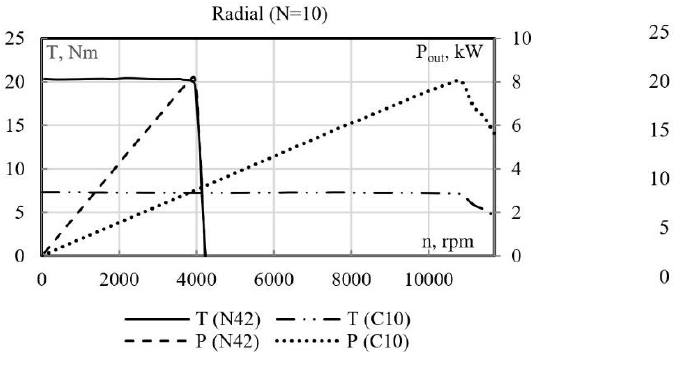
6 of 15 Figure 4. Electromechanical characteristics of the tangential and radial machines with N42 and C10 PMs for N = 20 turns. Here, the X -axis defines the speed of the machines and the Y -axis shows the